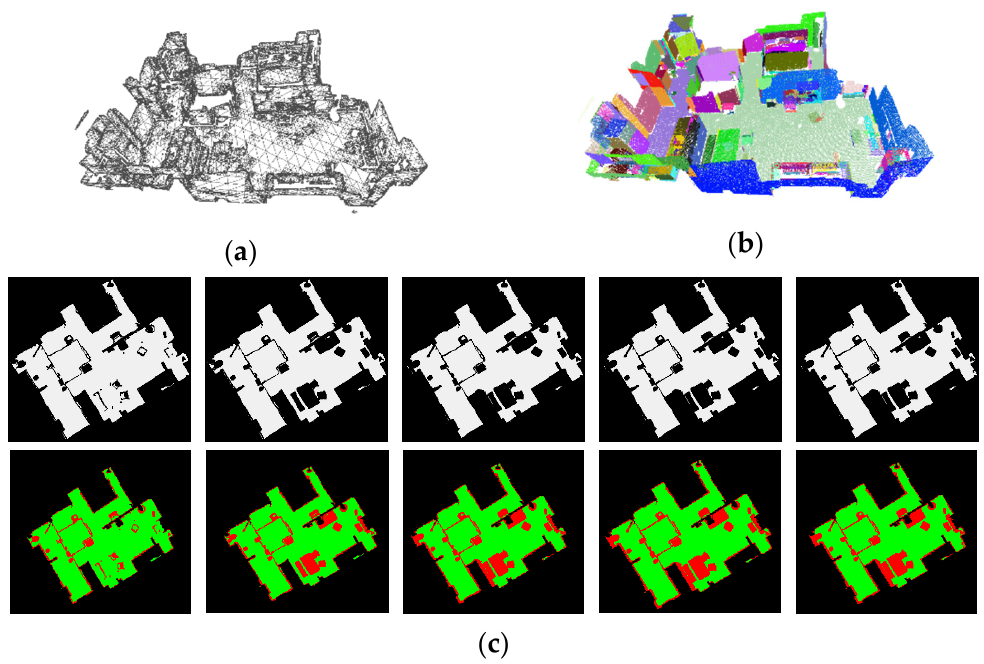
Figure 20. ISE result of real dataset 2: ( a ) FSM result, ( b ) original planar point cloud, and ( c ) PAM.